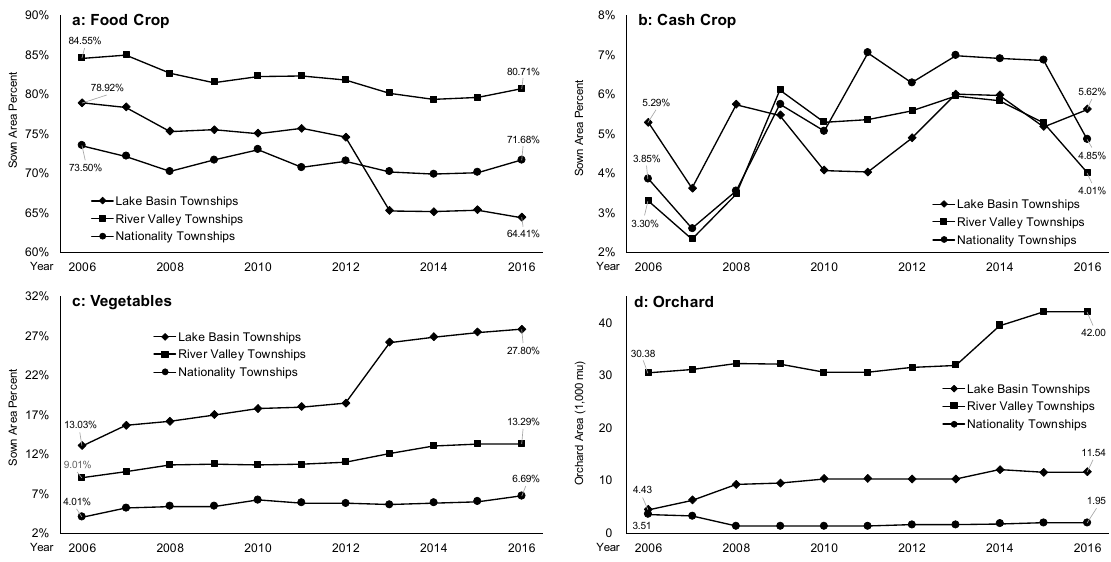
Figure 7. Agricultural sown area structure in the various township zones.